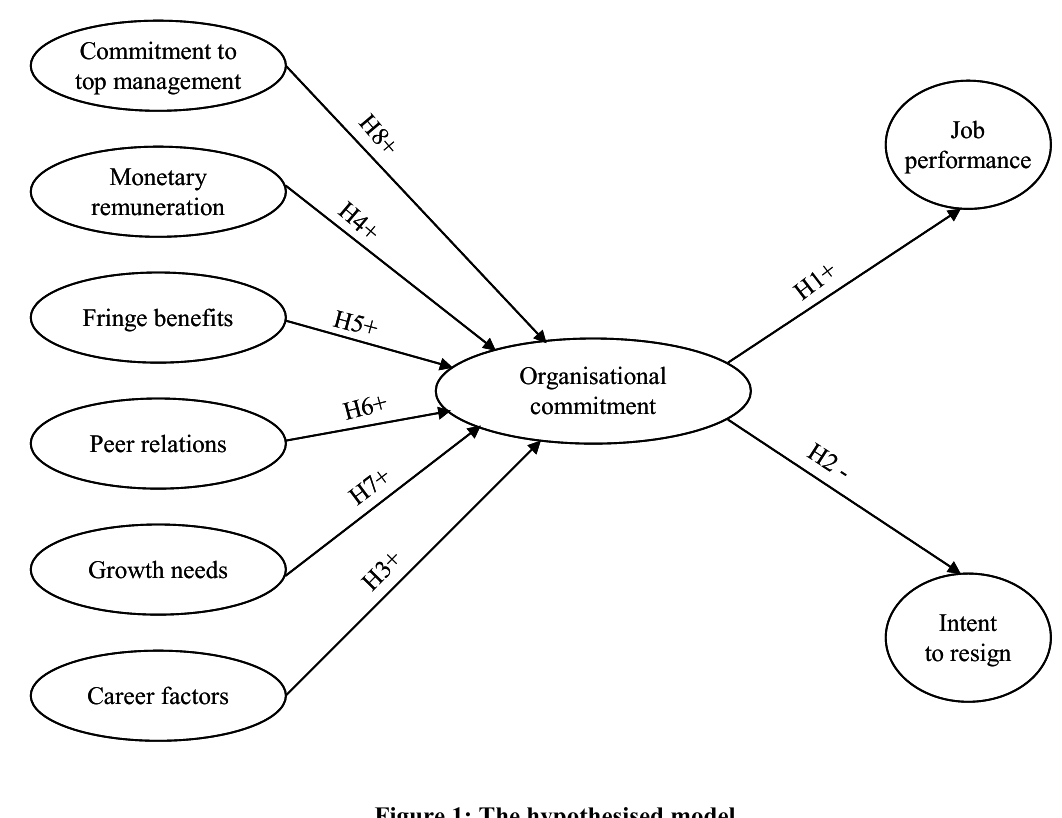
Figure 1: The hypothesised